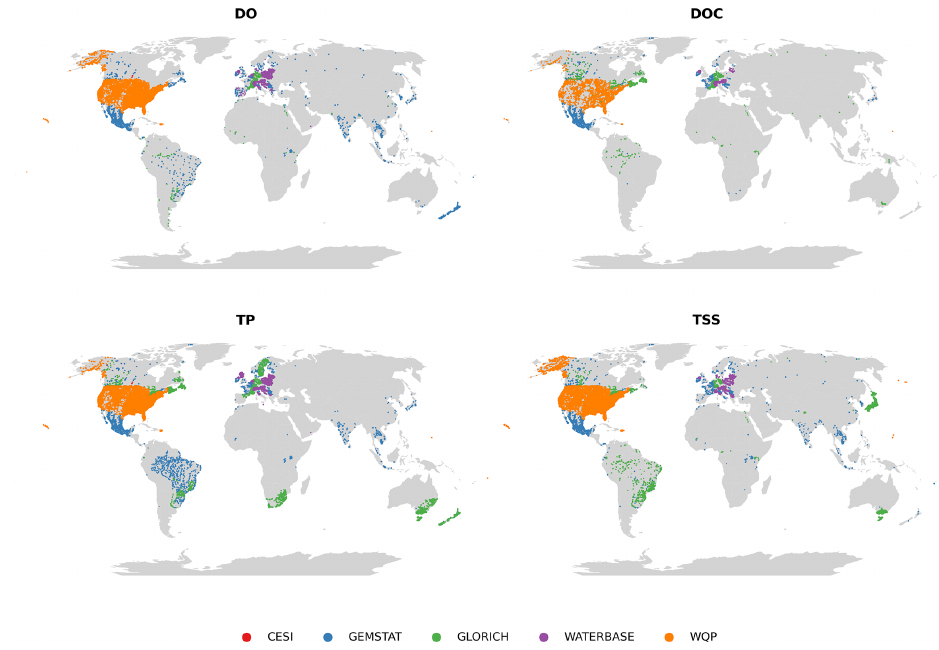
Figure 2. Distribution of observation sites for dissolved oxygen (DO), dissolved organic carbon (DOC), total phosphorus (TP) and total suspended solids (TSSs). Table 8. Summary table of observation time series statistics file